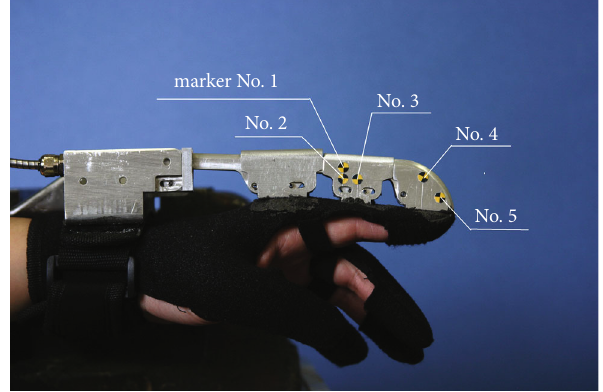
Figure 6: A sample image of the robotic exoskeleton with fi ve